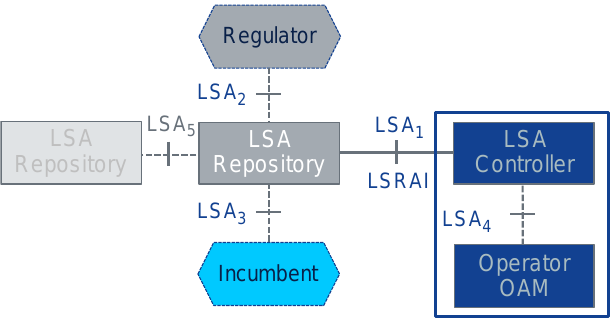
Figure 3. The LSA architecture reference